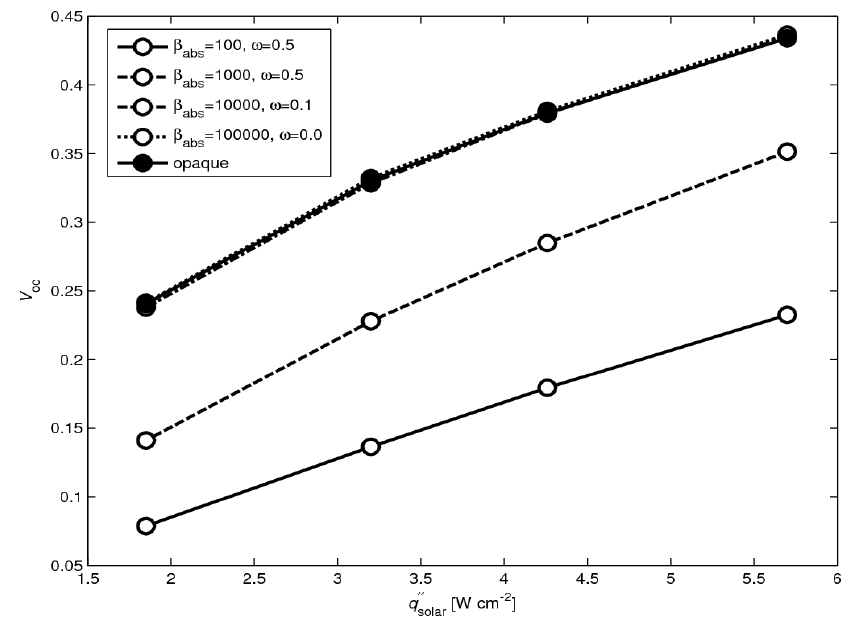
as a function of solar radiative flux for l = 10 mm for approach Figure 8. Simulated V OC (a) with β = 100, ω = 0.5; β = 1000, ω = 0.5; β absorber absorber = 100000, ω = 0.0 and for opaque approach β absorber